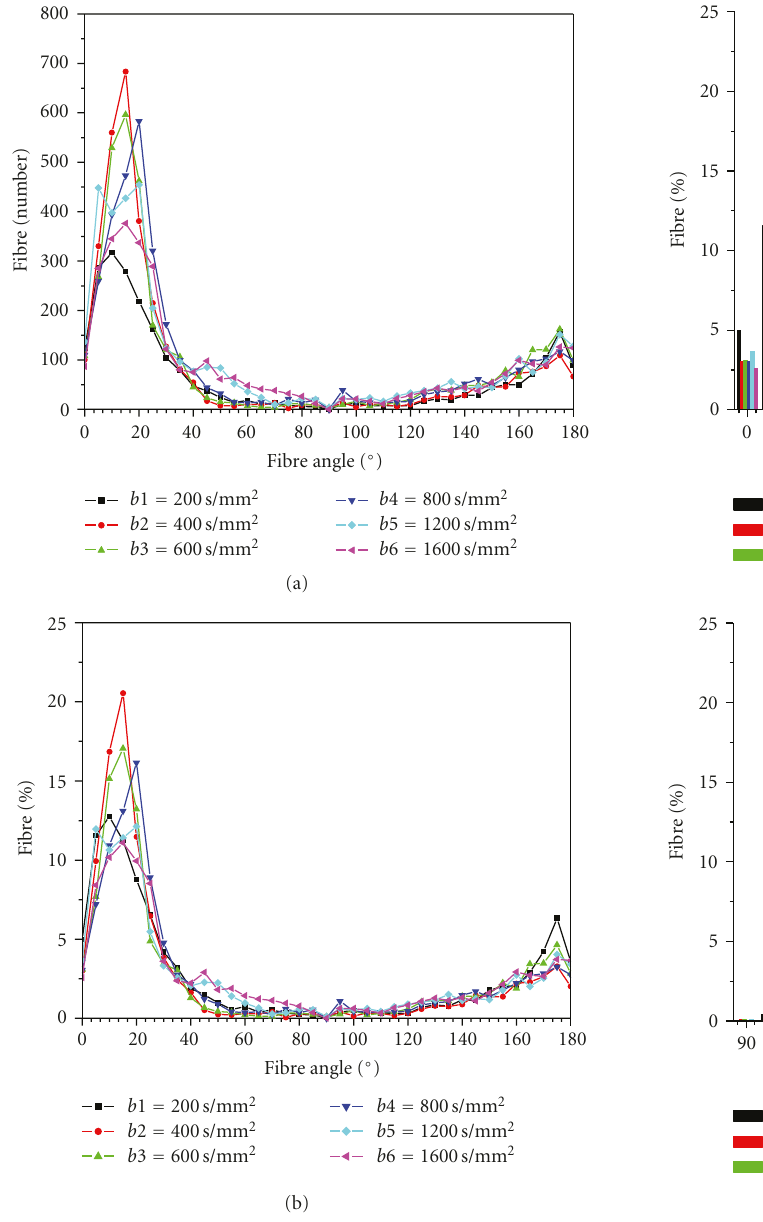
Figure 6: Distribution of the fibre angles over the analysed volume for di ff erent b values, (a) number of fibres; (b) percentages of fibres. The fibre angles are evaluated over bands of 5 ◦ and centered in the middle of each band.